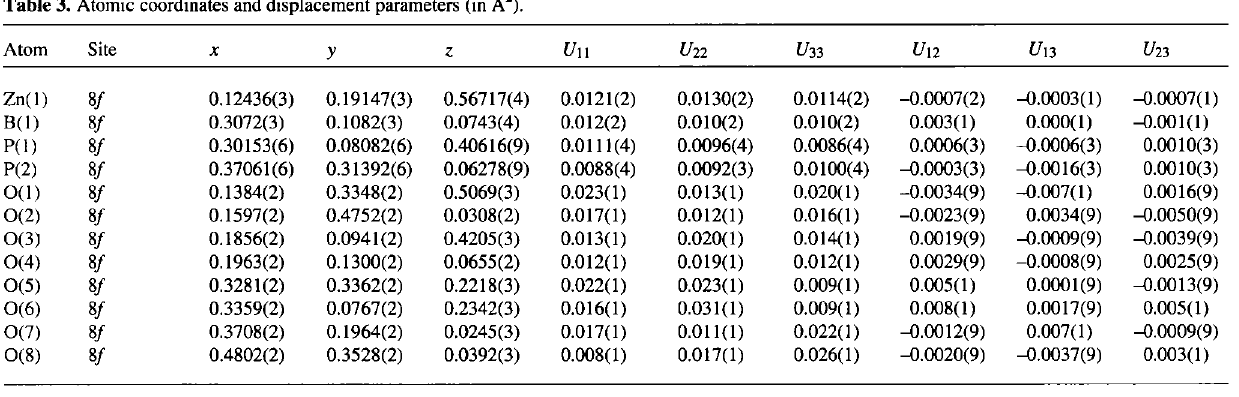
Table 3. Atomic coordinates and displacement parameters (in Ä 2